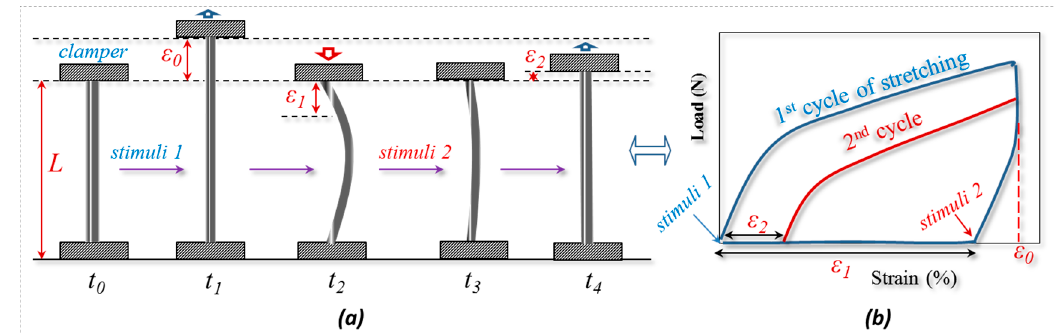
Figure 2. Stretching program of goat hair for quantitative characterization of the coupled shape memory effect (SME). ( a ) Five specific moments of the hair statuses in the program; ( b ) plot relationship of cyclic stretching load and strain of hair